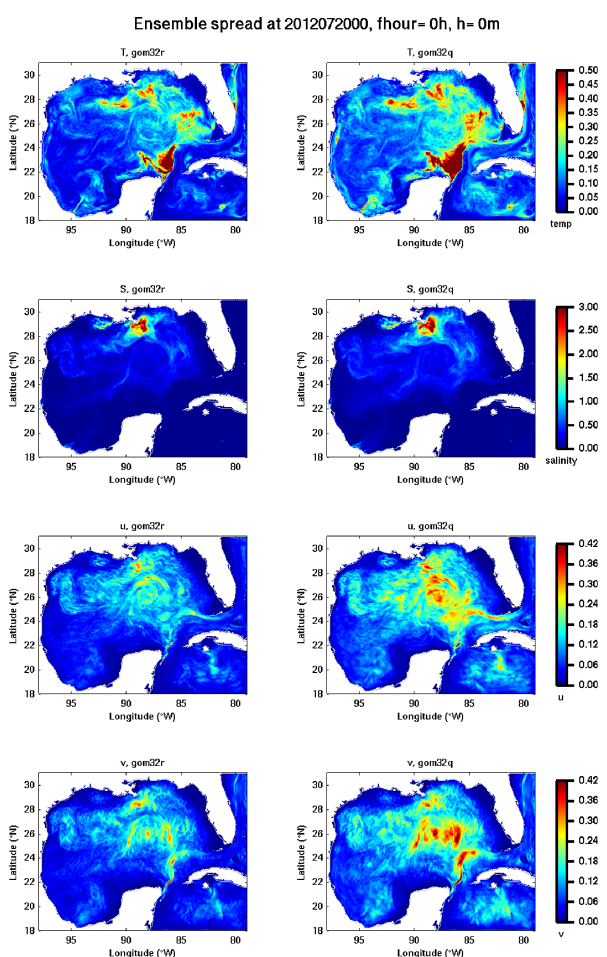
Fig. 1. Initial ensemble spread for r (left panel) and q (right panel) at 00:00UTC 20 July 2012 on the surface for temperature ( T ), salinity ( S ), u , and v (from top to